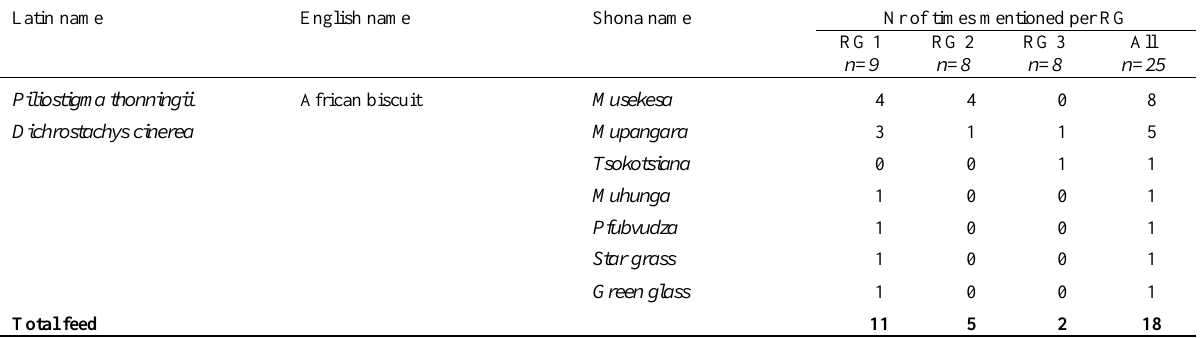
Table A3.8: Livestock feed, species names and collection scores.